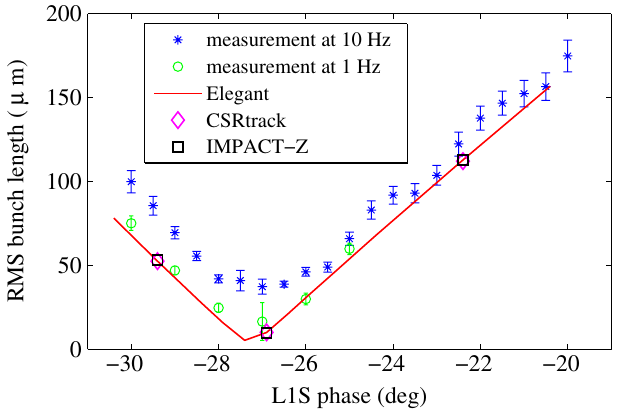
FIG. 3. (Color) BC1 compression measurements and simula- tions vs L1S phase (zero phase is on crest). The 1-Hz (green) measurements are thought to be more accurate, due to a screen persistence problem at 10 Hz